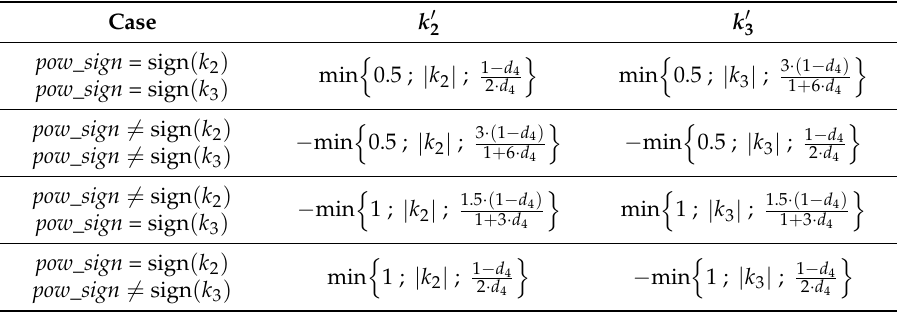
and k (cid:48) 2 3